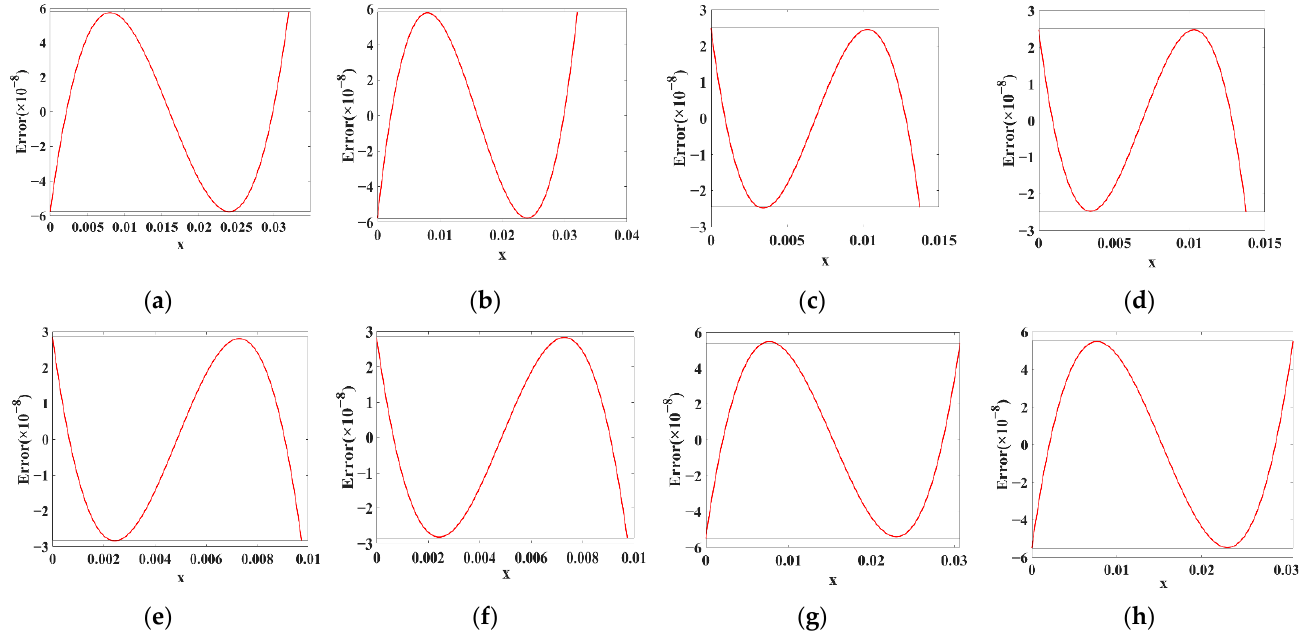
√ √ 1 + x, c2 = 0.500; ( d ) 1/ 1 + x, √ √ 1 + x, c2 = 0.500; ( h ) 1 + x, c2 = 0.498.